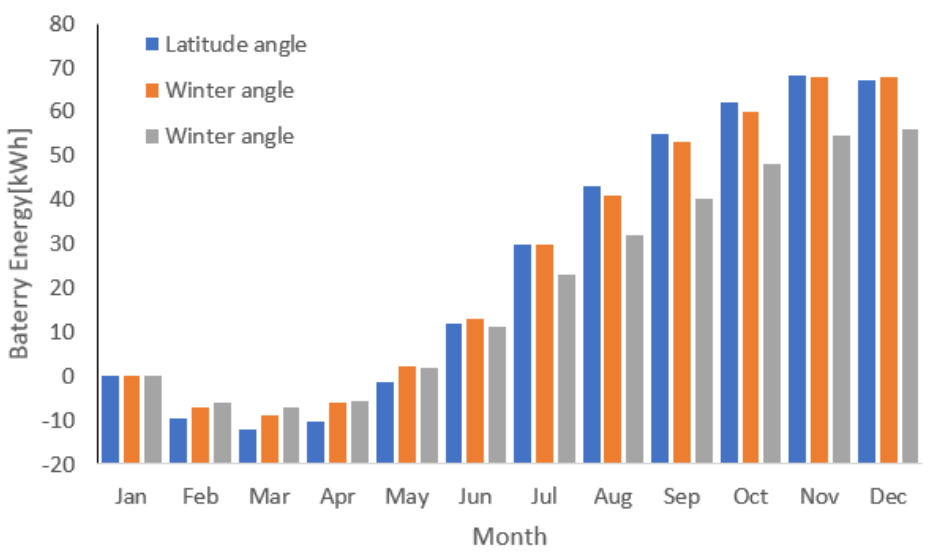
Figure 19. Battery energy stored for the 3 different solar tilt angles between the 13 January and 15 August.